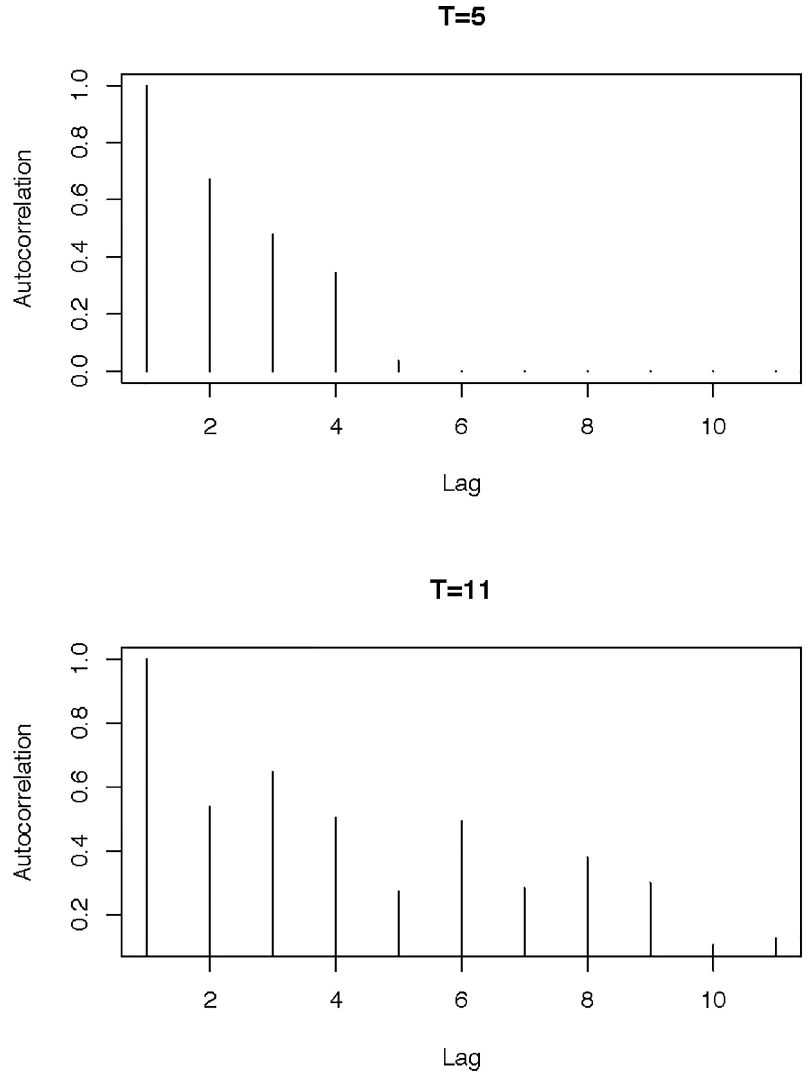
Fig 1. The autocorrelation functions for loadings f x